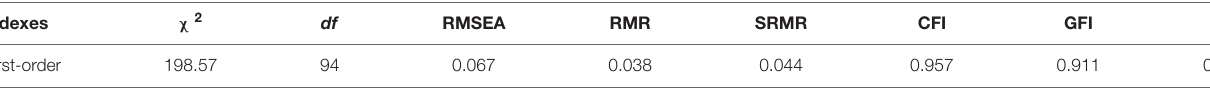
TABLE 2 | Goodness-of-fit indexes for five-factor model using the first-order